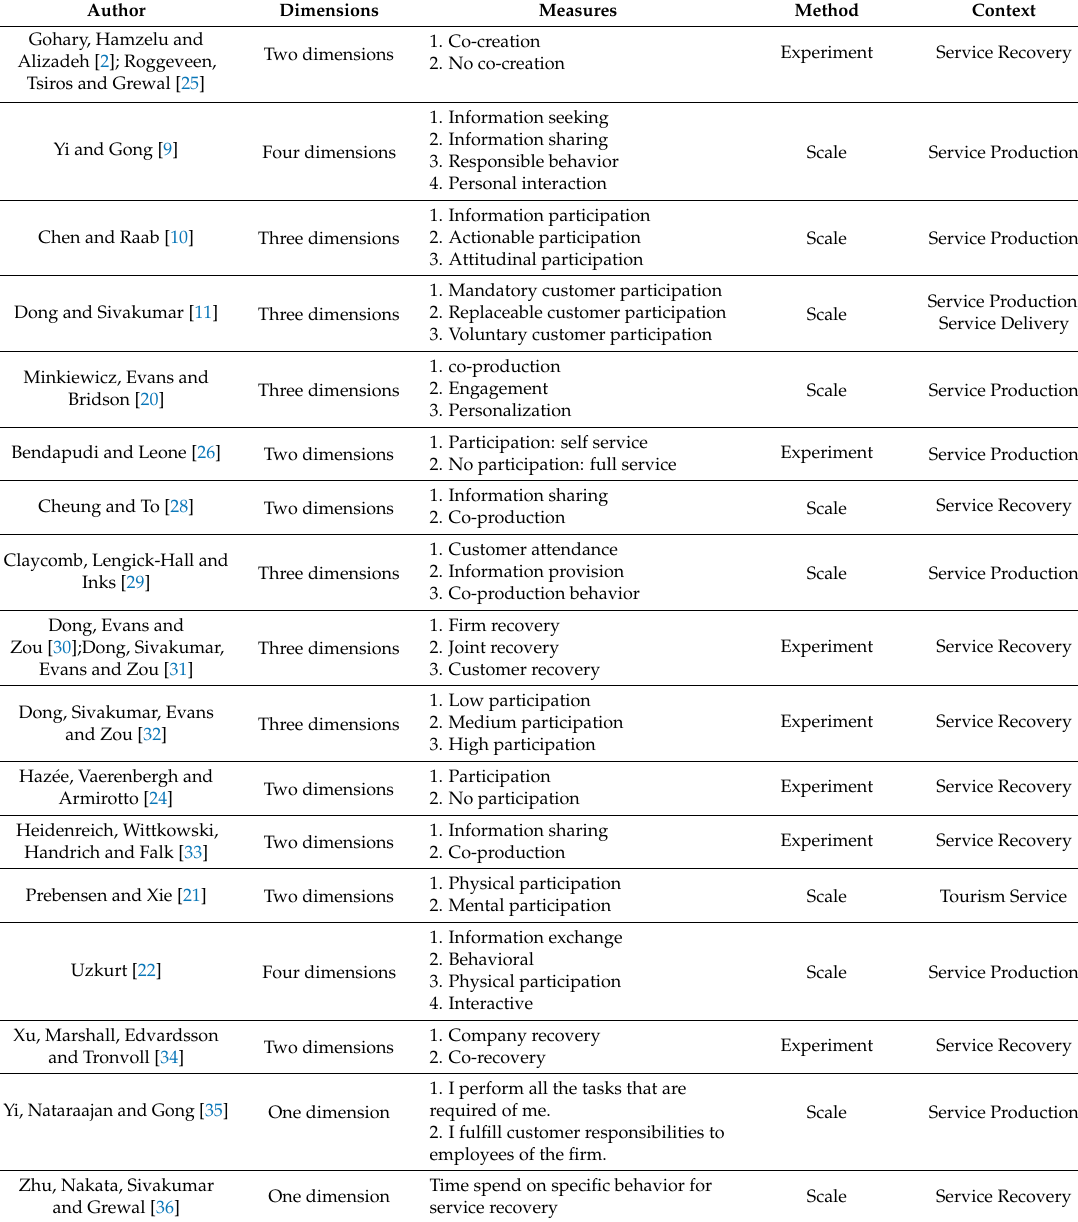
Table 1. Examples of customer participation composition in the